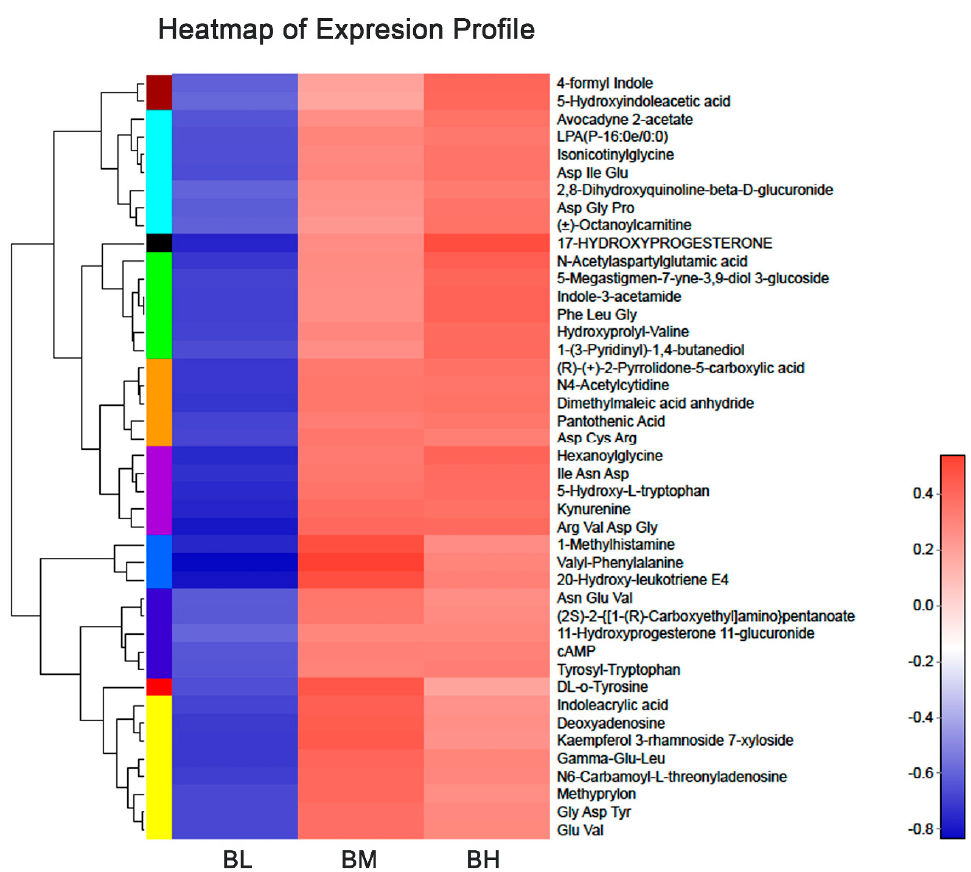
Figure 3. Heatmap of the levels of differentially expressed metabolites in each group at the baseline. The color of each section represents the abundance value of metabolite calculated by the relative quantitation normalization method. Each row corresponds to data for a spe-